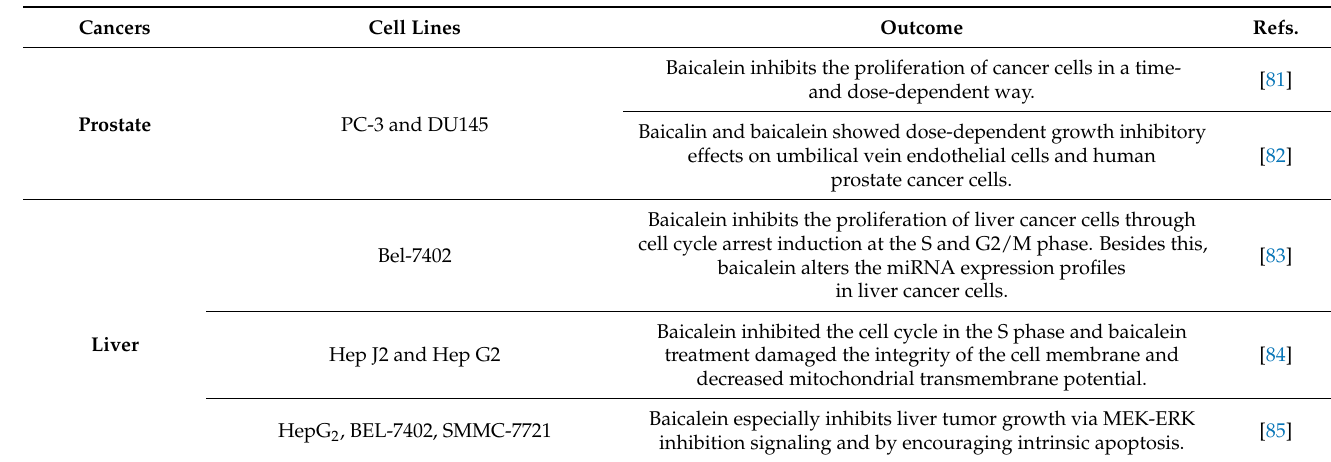
Table 2. The role baicalein in different types of